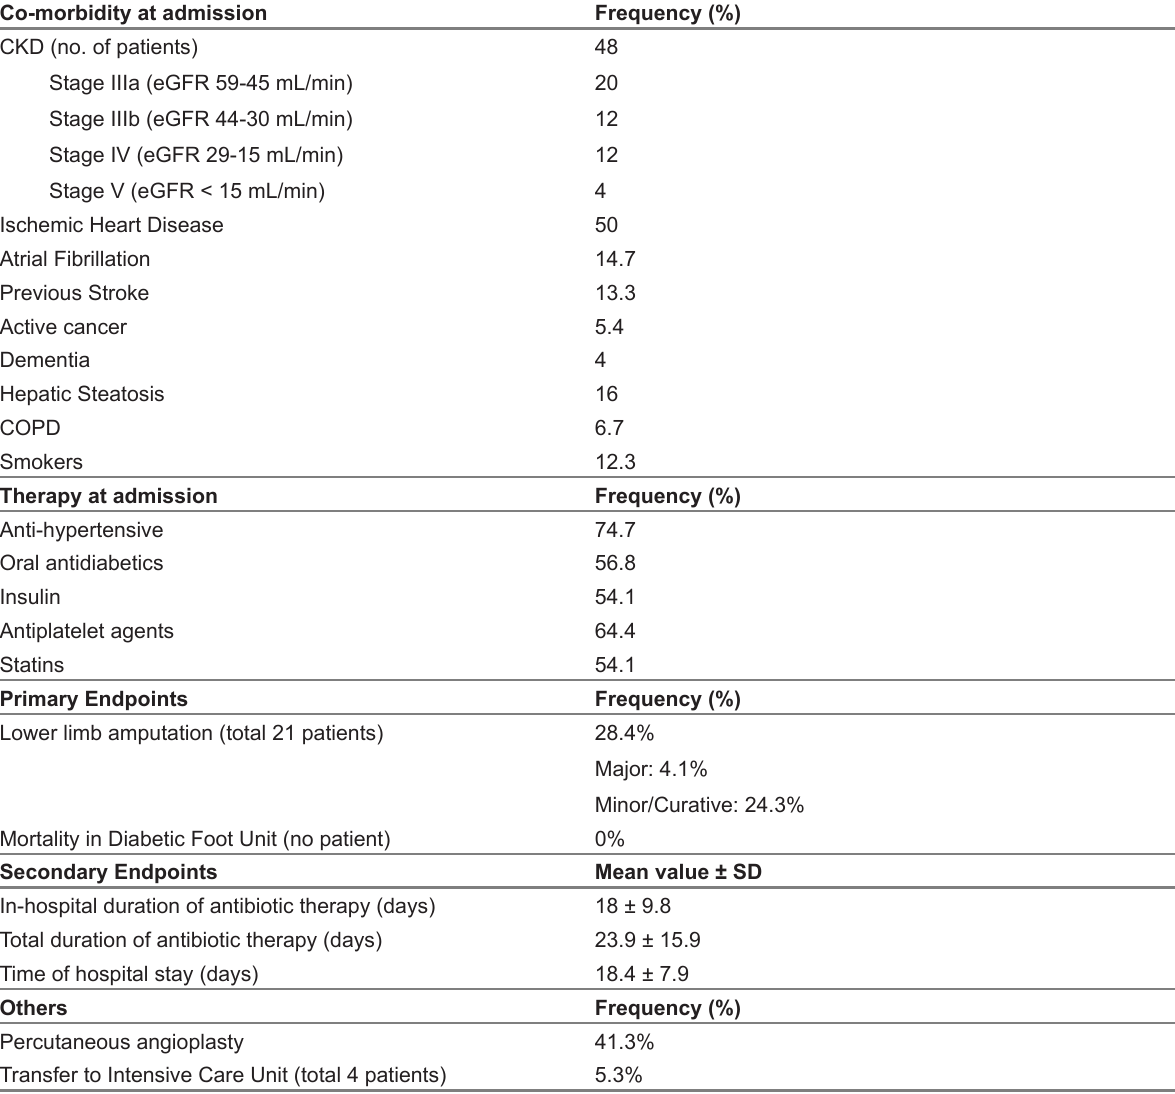
Table 1. Main demographic, diseases and therapeutic characteristics, and diagnostic and surgical interventions in the study population with DFS ( continued )